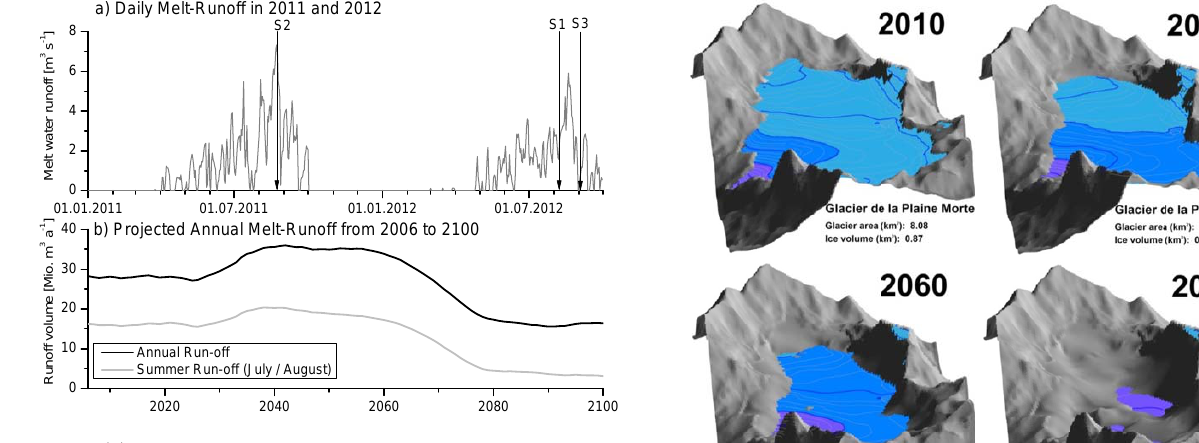
. Colors indic cate ce is indicated d in the